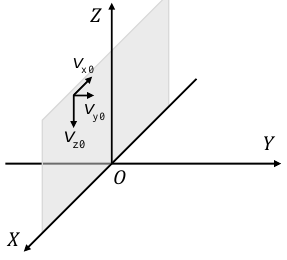
Figure 1. Three-dimensional powered descent coordinate